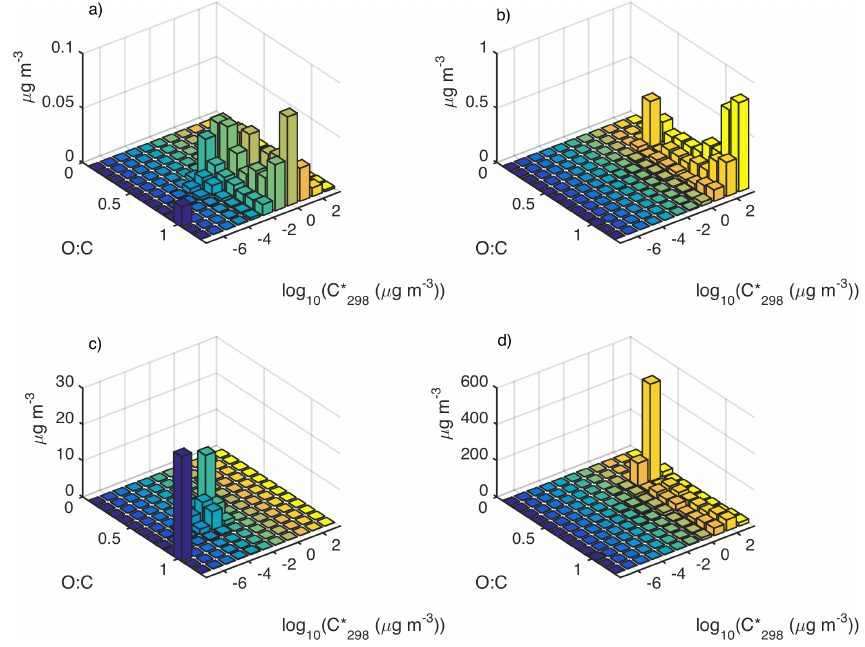
Figure 7. Modelled 2-D VBS distribution for (a) the SOA particles, (b) the gas phase, (c) the VOCs on the glass walls and (d) the VOCs on the Teflon floor. The model results are from Day 3 after 5hours with UV lights on. For this simulation Reactions (R1) and (R2) were used to simulate the ELVOC